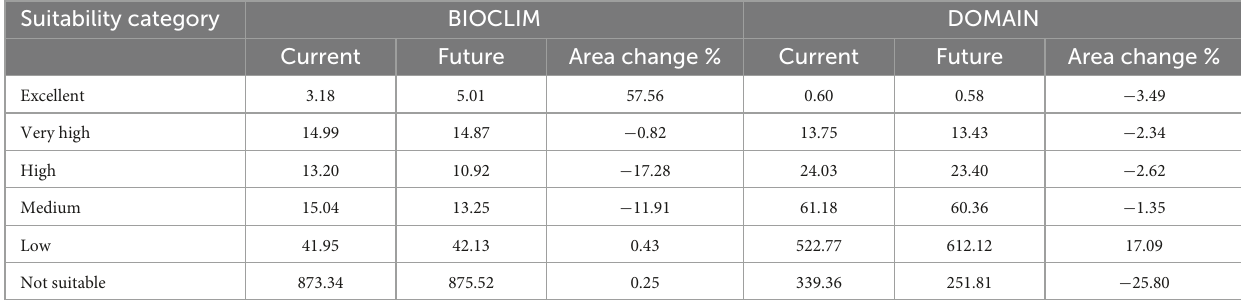
TABLE 1 Predicted suitable areas (10 4 km 2 ) for Mimosa bimucronata under the current and future climate scenarios are classified into five suitability